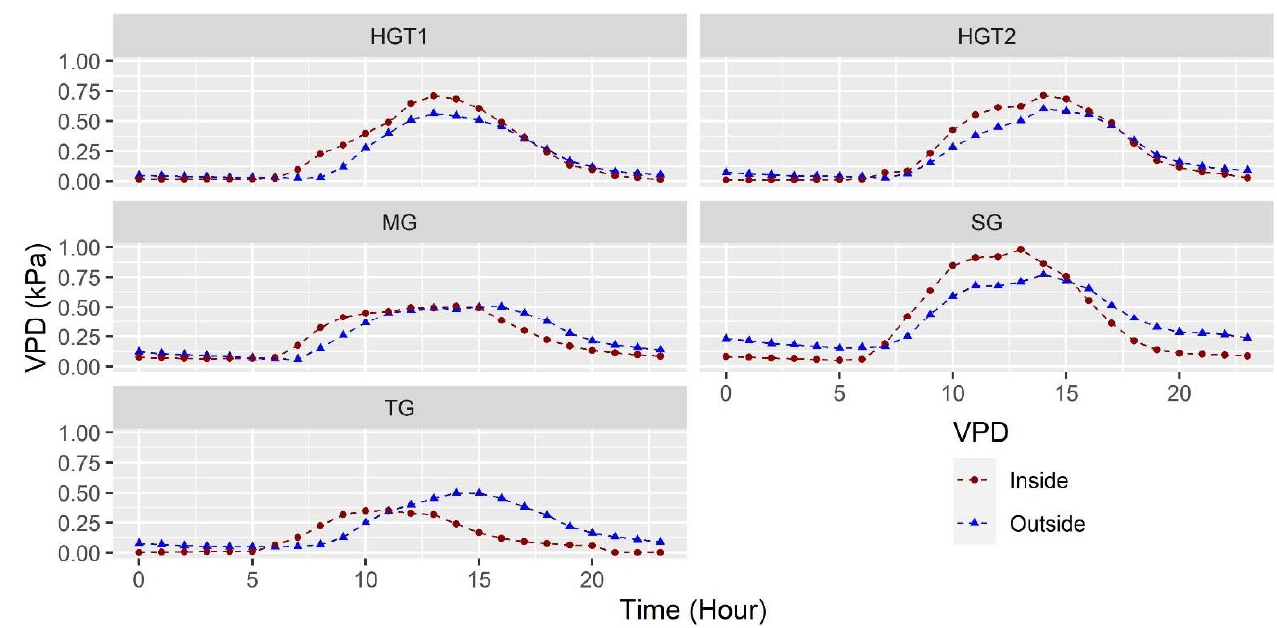
Figure 3. Mean VPD behavior for the 40 sensors in the indoor environment and mean outdoor VPD for each of the greenhouses evaluated.